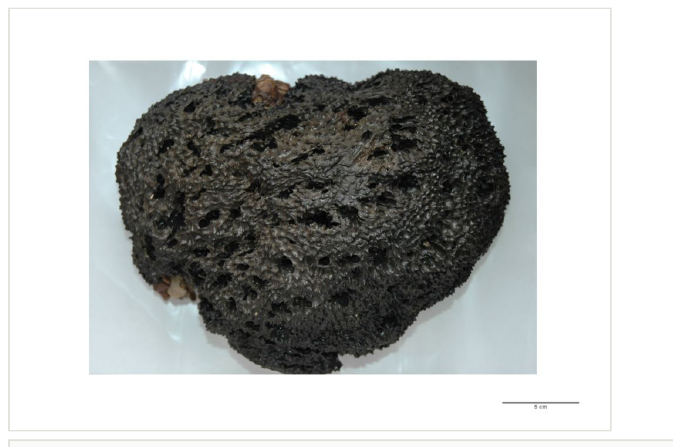
Photo of the demosponge Sarcotragus foetidus Schmidt, 1862, collected in the course of the